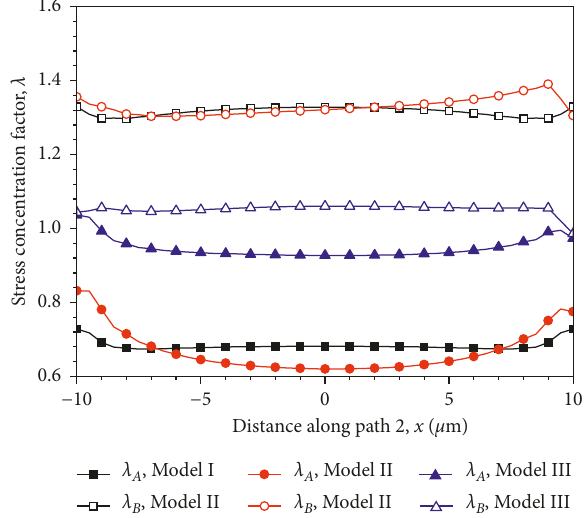
Figure 7: Mises stress concentration factor on the GB along path